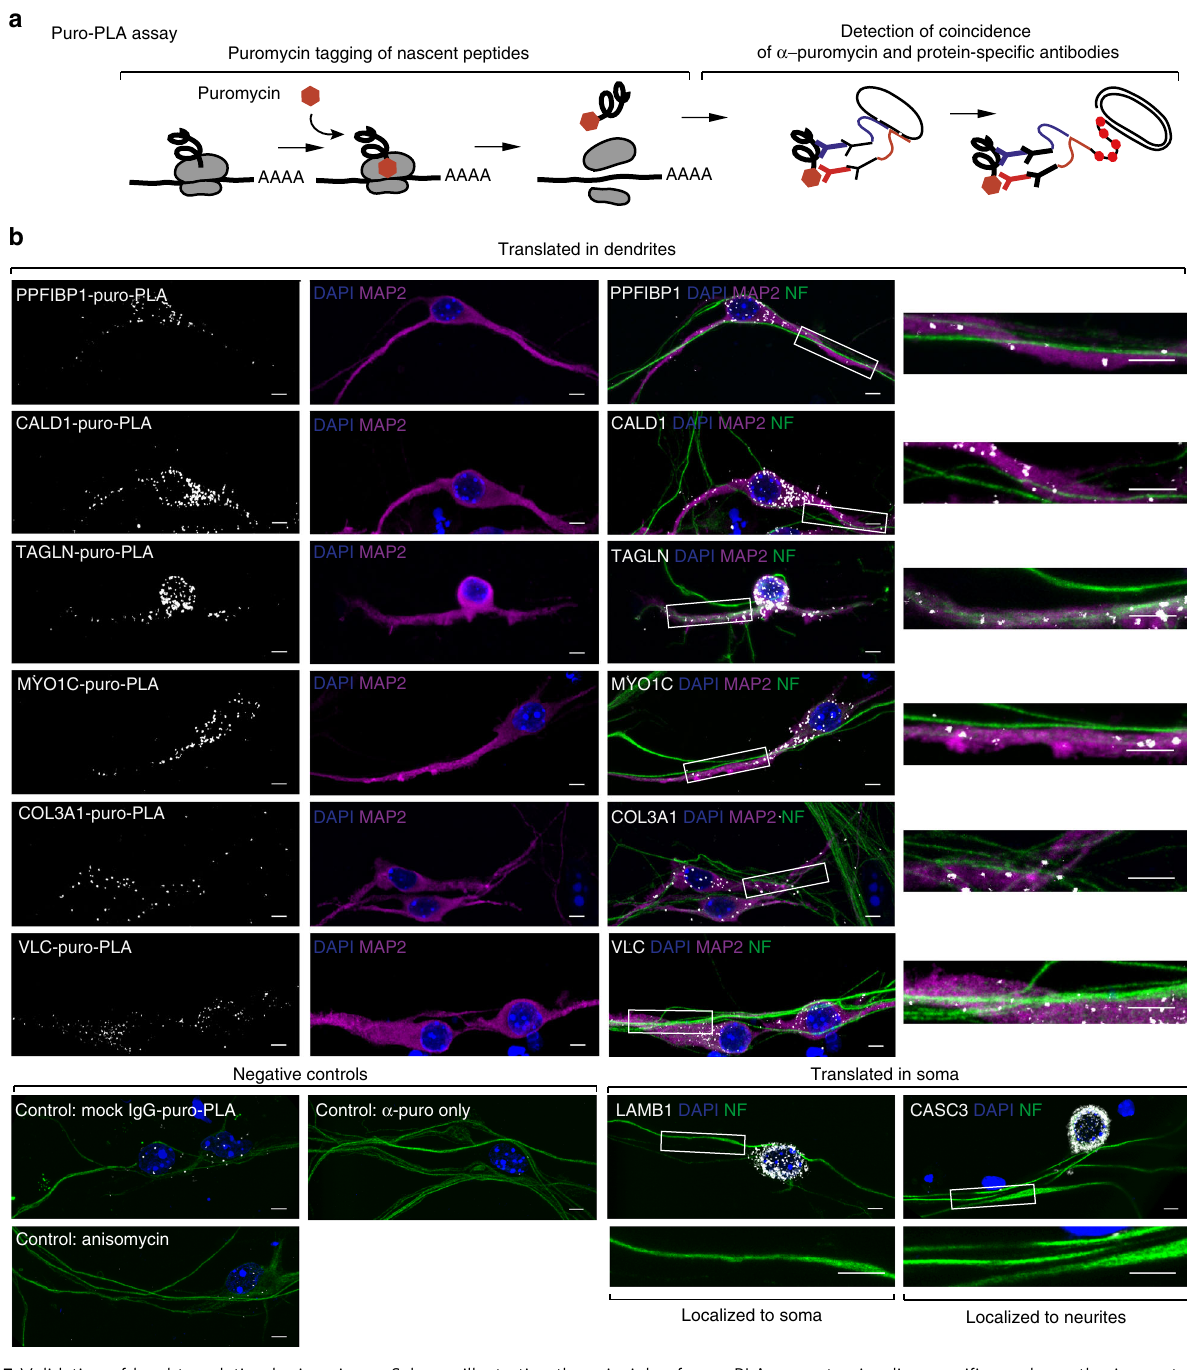
Fig. 5 Validation of local translation by imaging. a Scheme illustrating the principle of puro-PLA assay to visualize speci fi c newly synthesize proteins 34 . b Puro-PLA images of selected newly synthesized proteins in iNeurons. LMNB1 was used as reference for somatically produced proteins 34 . For negative control, cells were pretreated with the protein synthesis inhibitor anisomycin (anisomycin), protein-speci fi c antibody was omitted ( α -puro only) or mock rabbit IgG was used instead of speci fi c antibody (mock IgG-puro-PLA). Immunostaining with MAP2 ( magenta ) and NF ( green ) enables detection of dendrites (MAP2-positive neurites) and axons (NF-positive, but MAP2-negative neurites). COL3A1, MYO1C, CALD1 67 (Caldesmon), VCL 68 (Vinculin), TAGLN 69 (Transgelin), and PPFIBP1 are examples of neurite-translated proteins (Ribo-seq log2 neurites/soma = 2.4, 0.9, 1.2, 1.4, 3.7, and 2.1 correspondingly). Btz/CASC3 is a protein that showed no preferential translation in neurites (Ribo-seq log2 neurites/soma = − 0.2). Magni fi cations of neurite sections (inserts) shown next to the images. Scale bar = 5 μ m. Puro-PLA signal ( white ), NF ( green ), MAP2 ( magenta ), DAPI ( blue ). See also Supplementary Fig. 7 for puro-PLA validation on hippocampal neurons and different length of puromycin